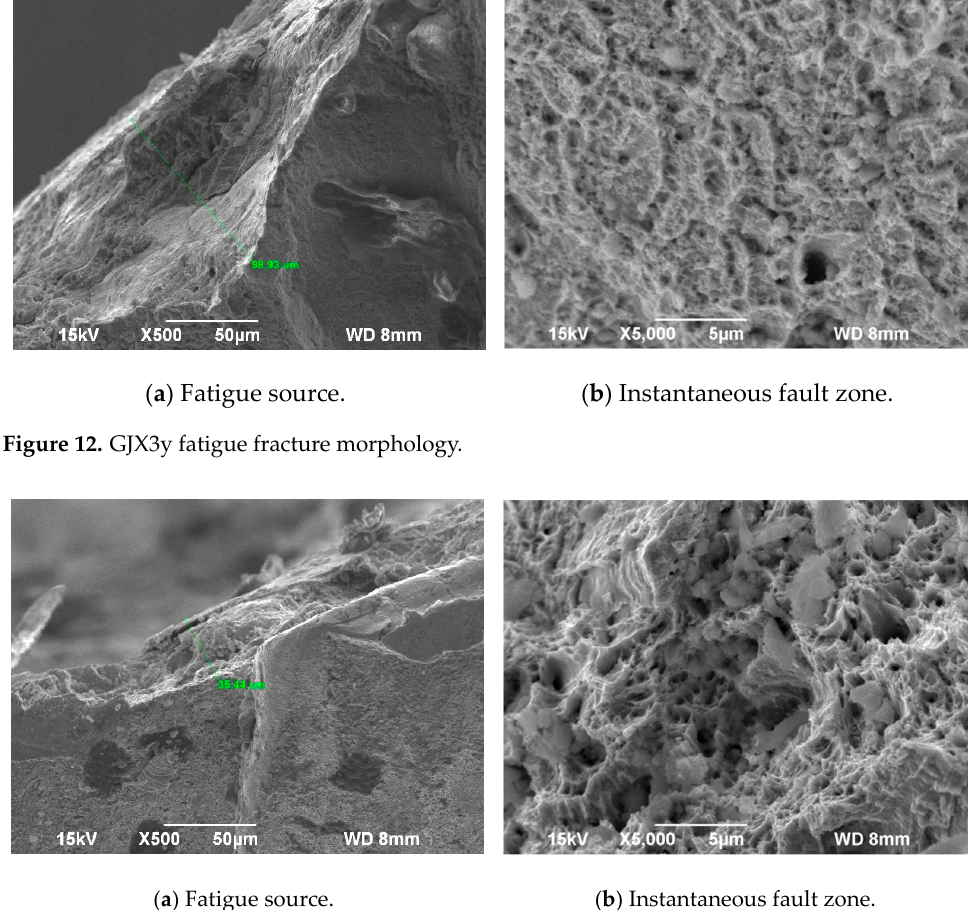
Figure 13. GJX6y fatigue fracture morphology.